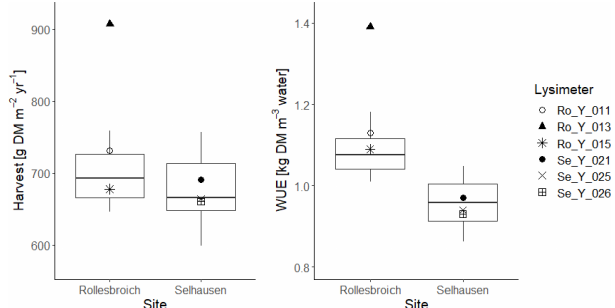
Figure 11. Box-and-whisker plots of simulated harvests and water use efficiency (WUE; defined as total harvest divided by evapotran- spiration) at Selhausen and Rollesbroich for the period 2013–2018 for the 30 acceptable simulations compared with lysimeter measure- ments (symbols). For an explanation of the box-and-whisker plots, see the caption of Fig. 3.